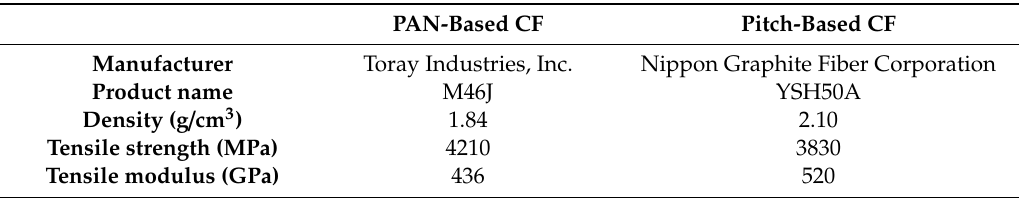
Table 1. The manufacturer and physical properties of commercial polyacrylonitrile (PAN-) and pitch-based carbon fibers (CFs) in this